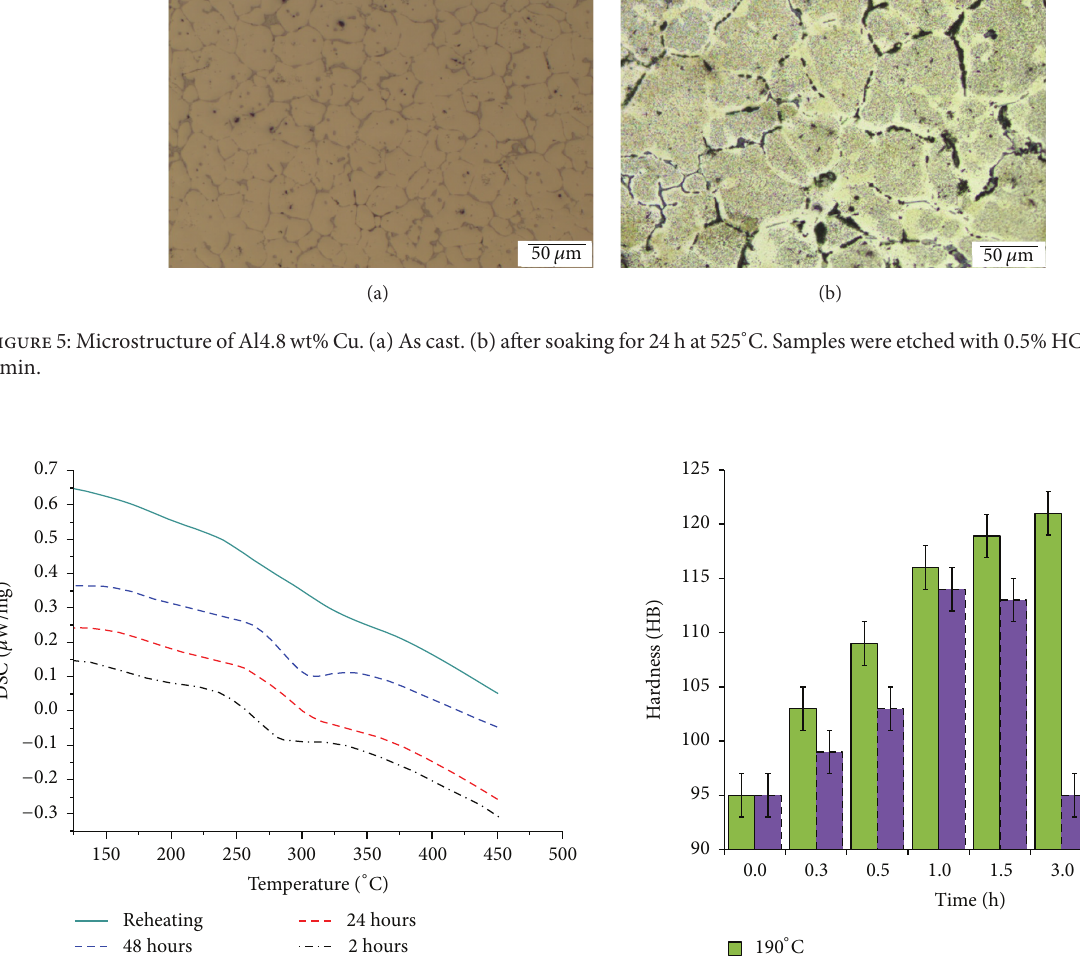
Figure 6: Differential scanning calorimetry of solutionized samples Al4.8 wt% Cu. Peaks show precipitation in the recycled aluminum alloy.